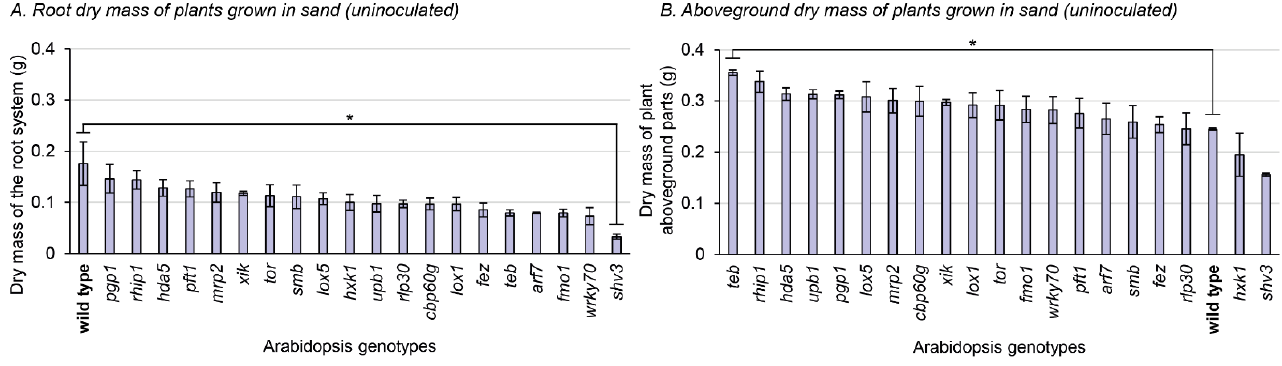
Figure 3. Dry mass of roots and aboveground parts of 21 A . thaliana genotypes grown in sterile sand (not inoculated). Asterisks refer to significant differences between the wild type and another genotype, defined by Fisher’s least significant difference test. * p -value < 0.05. Bars indicate standard errors ( n = 3). ( A ) Root dry mass of plants grown in sand (uninoculated). ( B ) Aboveground dry mass of plants grown in sand (uninoculated).